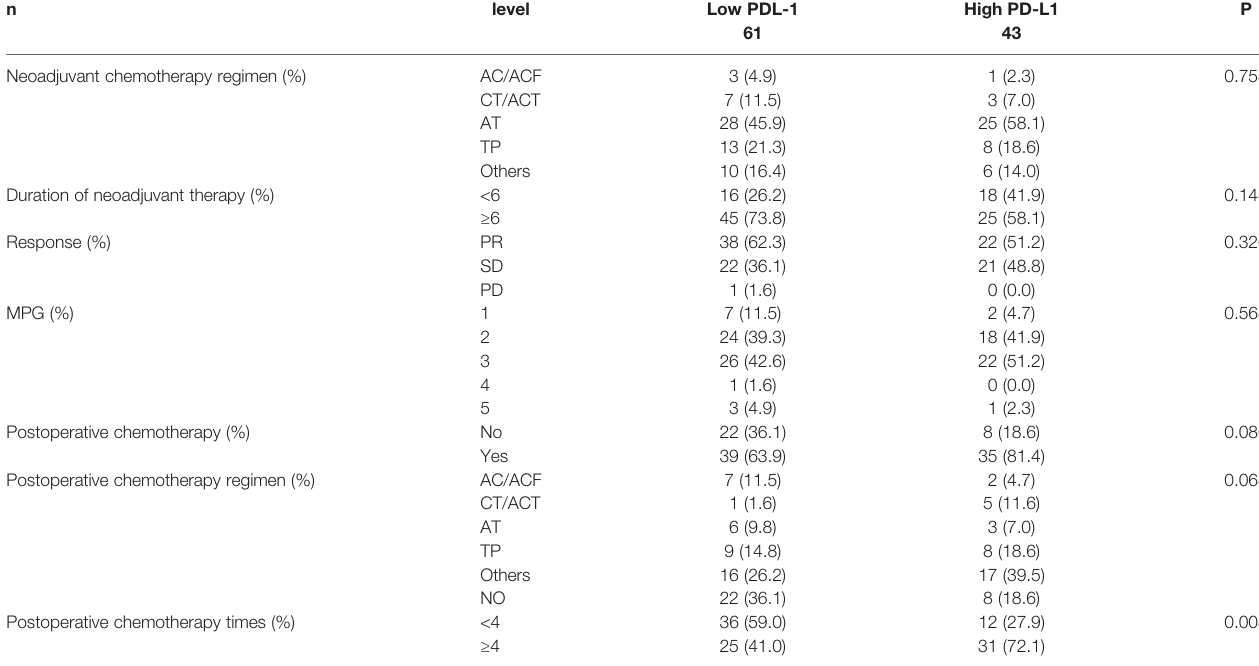
TABLE 3 | Patients ’ chemotherapy for all patients according to programmed cell death ligand-1 (PD-L1). n